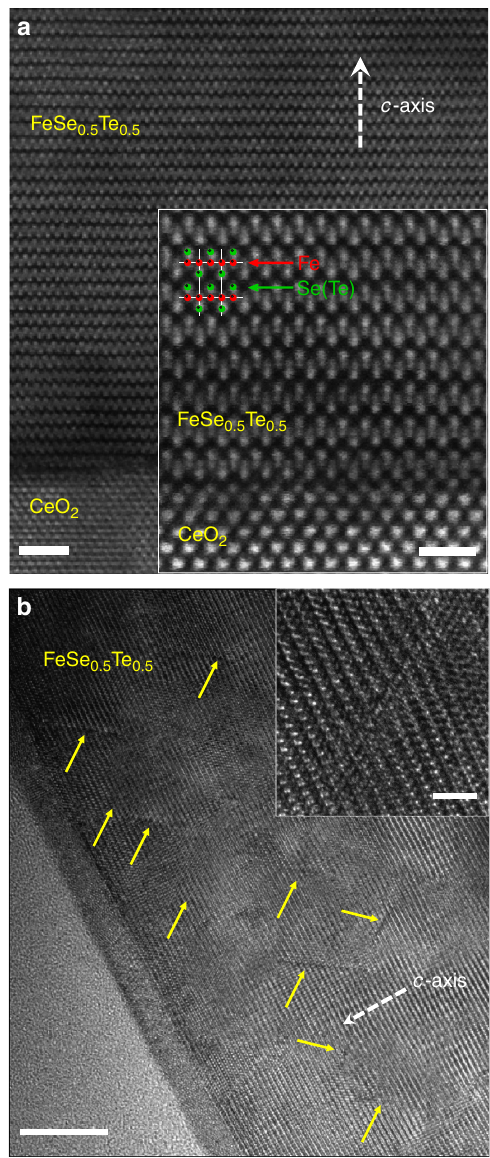
Figure 2 | Microstructure of FST films. ( a ) STEM-HAADF images of the representative FST film on the CeO 2 buffer layer. Scale bar, 2nm. Inset: high-resolution image at the interface between CeO 2 and FST. Scale bar, 1nm. ( b ) HRTEM image of FST film irradiated with 190keV proton. Scale bar, 10nm. Inset: high-resolution image of splayed cascade defect and strain field produced by 190keV proton irradiation. Scale bar,